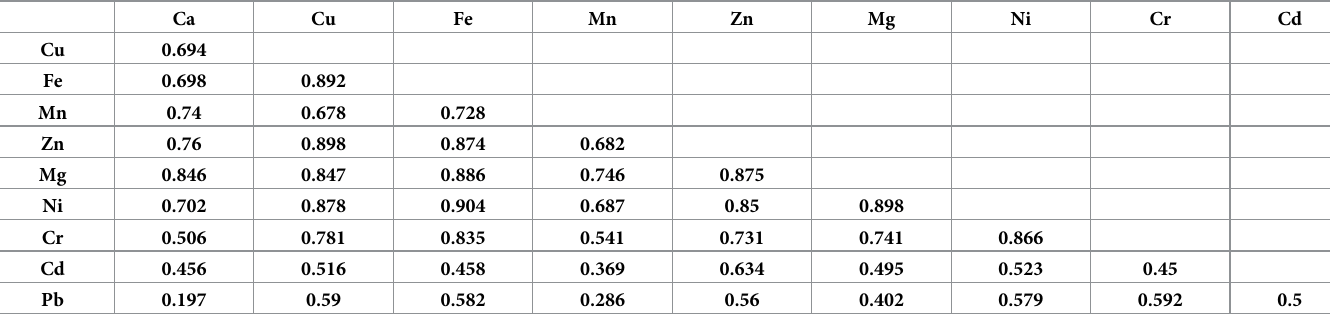
Table 3. Spearman coefficients between metal elements (sample number = 300, p <